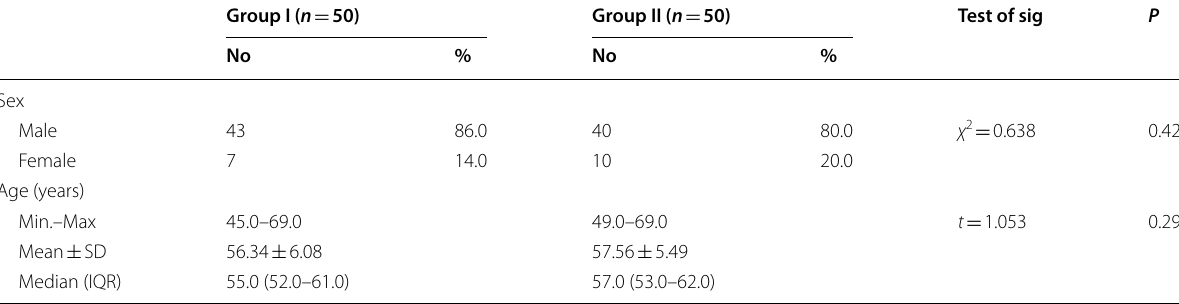
Table 1 Comparison between the two studied groups according to demographic data